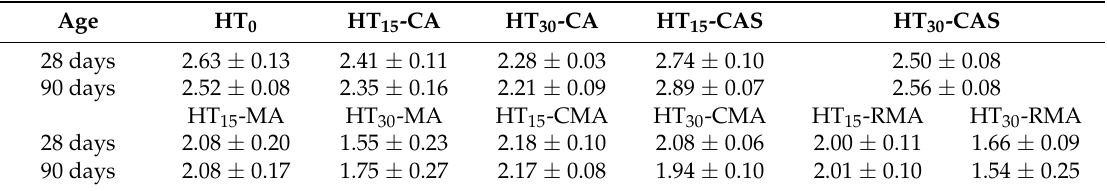
Table 7. Results of concentrated load test (kN), of hollow tiles, as a function of the aggregate type, dosaging method (see Table 5 for nomenclature), and time.